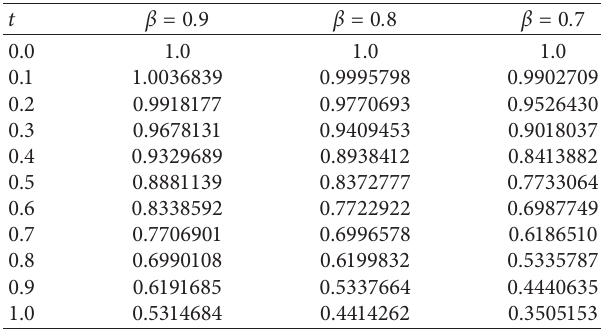
Table 8: Numerical results of approximate solution v Example 2 for different values of β , k � 6, and t ∈ [ 0 , 1 ]